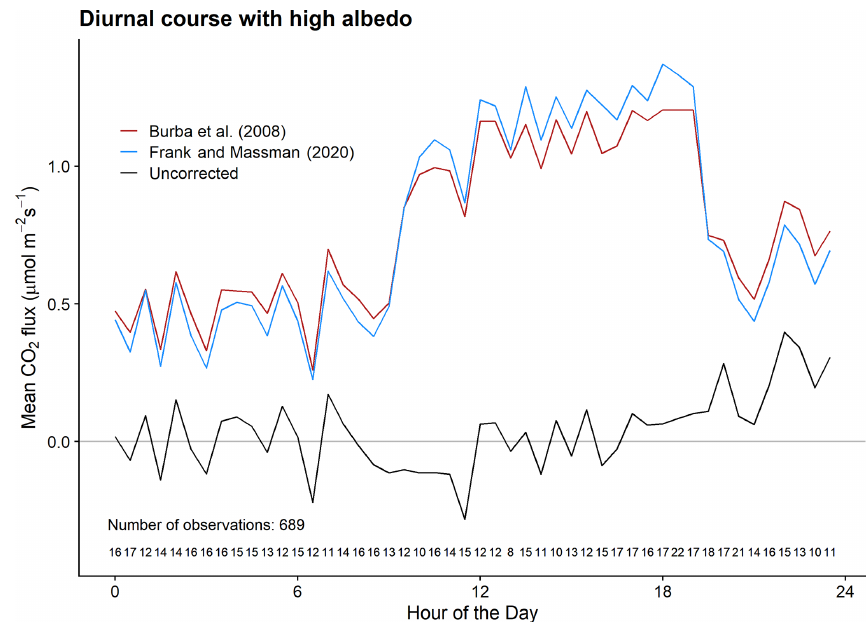
Figure A1. Mean diurnal course of the original and SSH-corrected (Burba et al., 2008; Frank and Massman, 2020) CO 2 fluxes during cold periods (air temperature lower than 0 ◦ C) and closed snow cover (short-wave albedo greater than 0.8). Note that a closed snow cover is rarely found at our site; therefore, the number of data points is limited. Most data originate from the winter of 2006–2007.